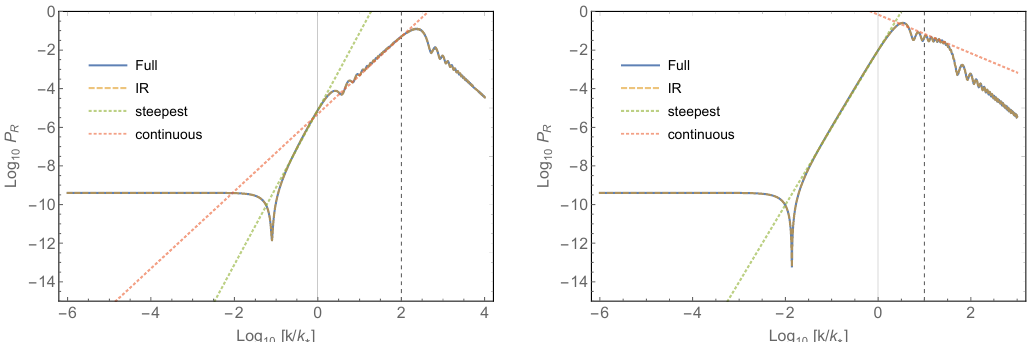
Figure 3 . The power spectrum P R given by (3.5) with H k = 10 − 5 in Planck unit from the phases of slow-roll (Phase 1) to negative-constant-rate (Phase 2) with δ 2 = − 2 (left panel) and δ 2 = − 3 . 5 (right panel). The dashed-vertical line is k = k ∗∗ , and for k > k ∗∗ a positive-constant-rate δ 3 = 1 is used in Phase 3. The late-time (IR) expansions of the power spectrum (3.6) in terms of the dashed lines are in well agreement with the full expression (3.5) in solid